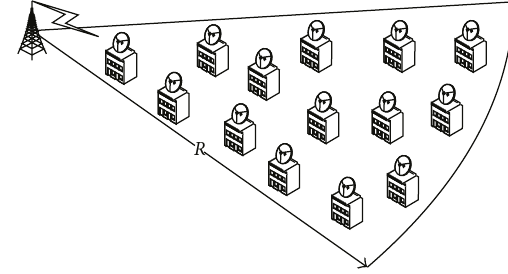
Figure 6: Sector with uniformly distributed SSs.